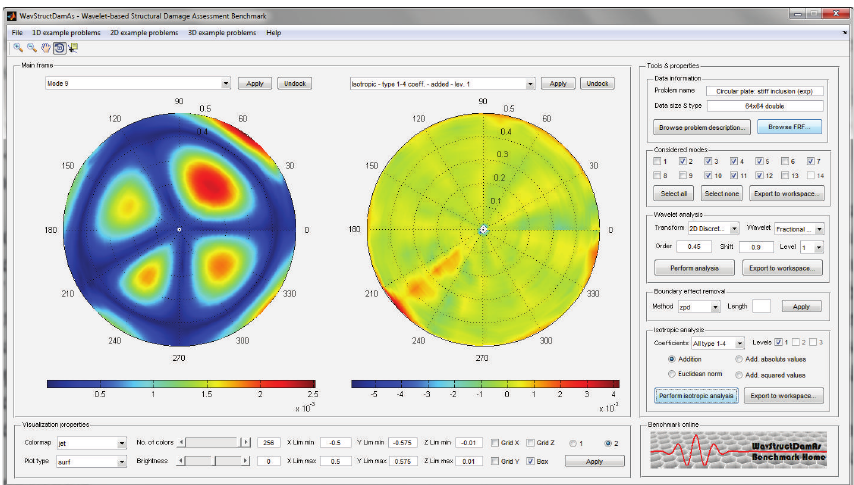
Figure 12: The benchmark results for SDI in a circular composite plate with stiff inclusion using isotropic FrDWT-based algorithm applied to selected modal shapes.